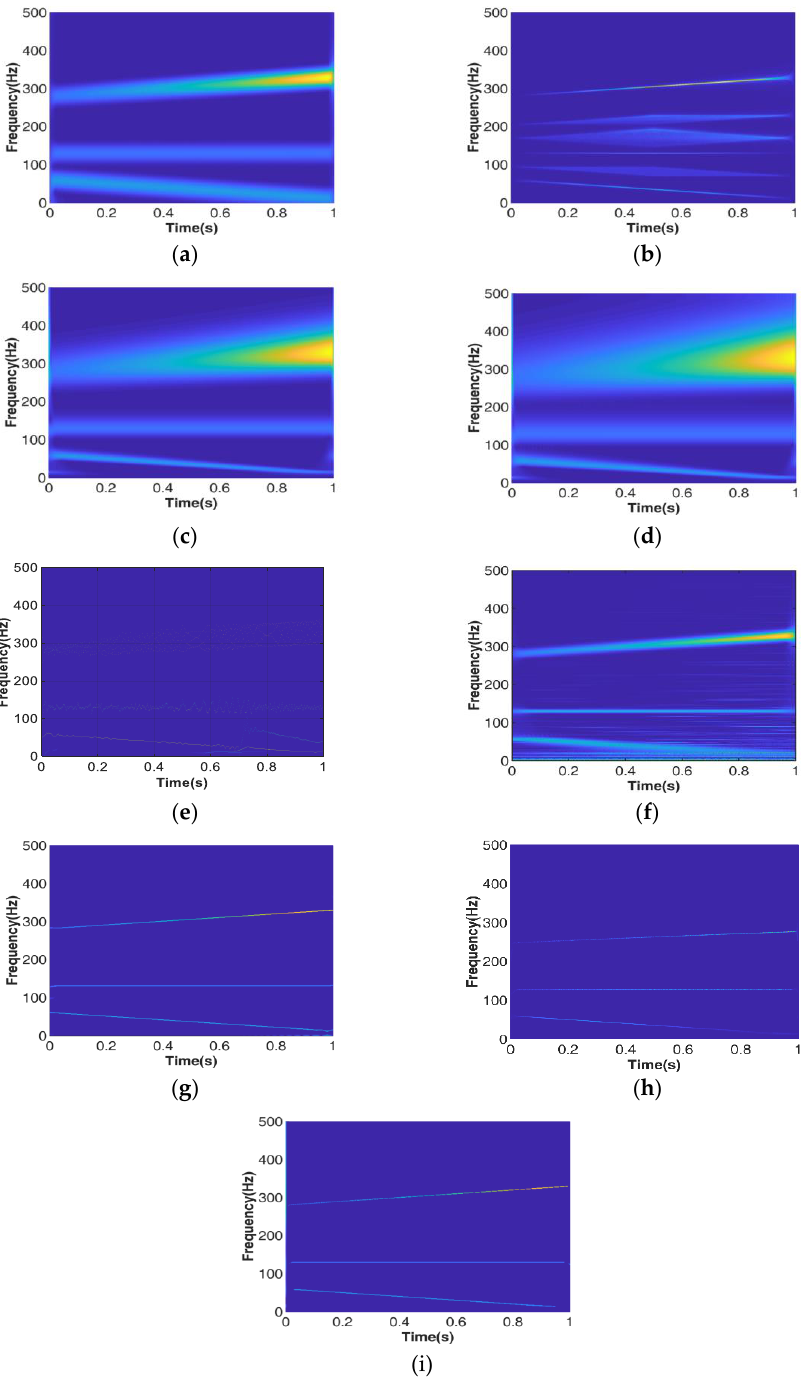
Figure 6. Comparison of various transform time-frequency representations of rotor vibration fault signals without noise. ( a ) STFT ; ( b ) WVD ; ( c) GST ; ( d ) ST ; ( e ) HHT ; ( f ) WT ; ( g ) SET ; ( h ) SWT ; ( i ) signals without noise. ( a ) STFT ; ( b ) WVD ; ( c ) GST ; ( d ) ST ; ( e ) HHT ; ( f ) WT ; ( g ) SET ; ( h ) SWT ; ( i ) SEST SEST .